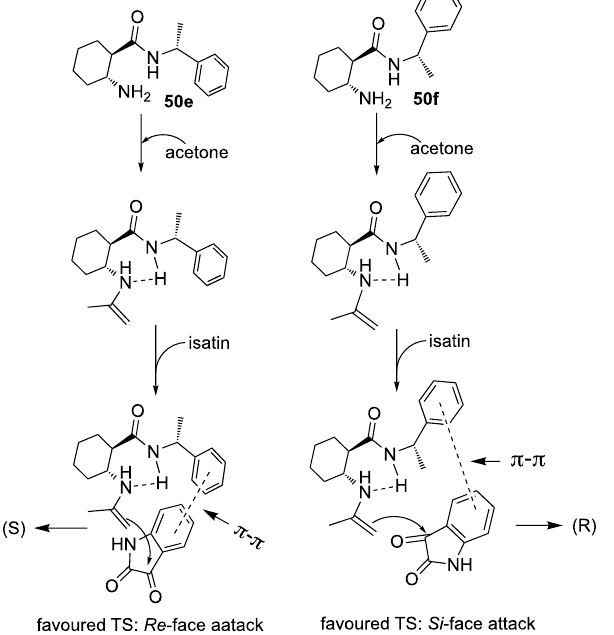
Scheme 21. Proposed mechanism of aldol reaction using β -amino amides as organocatalysts.